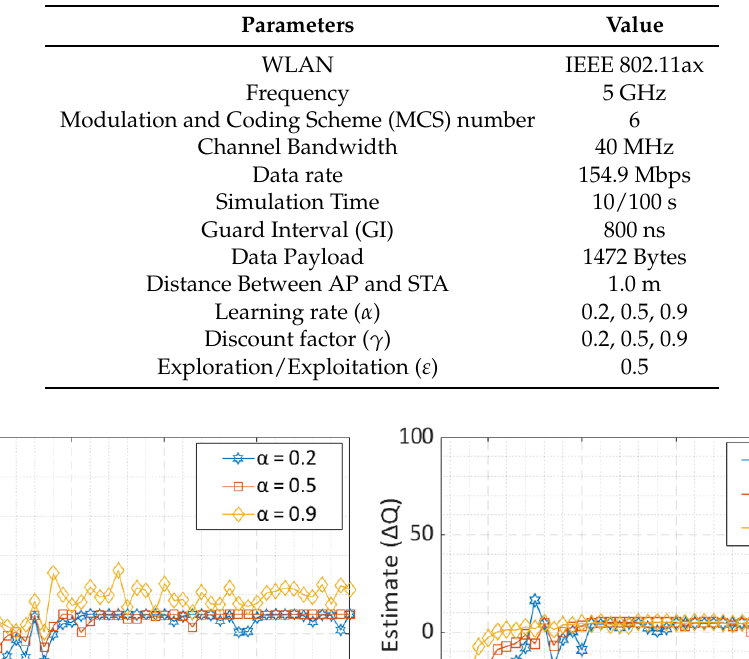
Table 1. A few of the important simulation parameters.